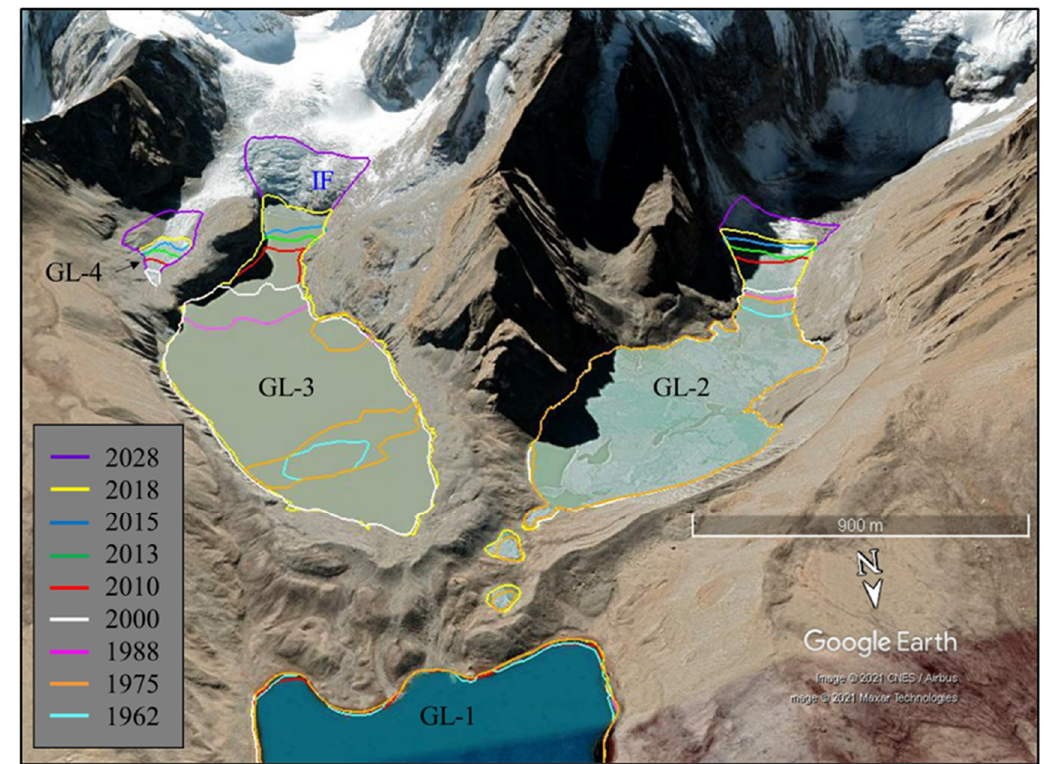
Figure 9. Future possible lake extent in 2028 based on the rate of length changes of the associated glaciers: GL − 2 (23.9 m a − 1 ), GL − 3 (45.6 m a − 1 ) and GL − 4 (21.4 m a − 1 ). The purple colour marks the projected lake areas in 2028. Note: IF, icefall region of Gurudongmar Khangse.